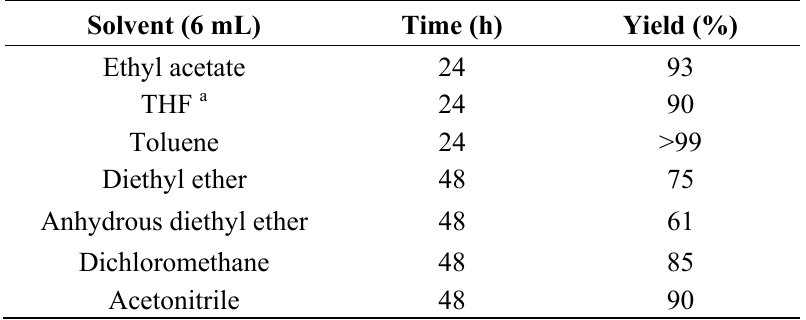
Table 2. Acetylation of 4-nitrobenzyl alcohol using different solvents.